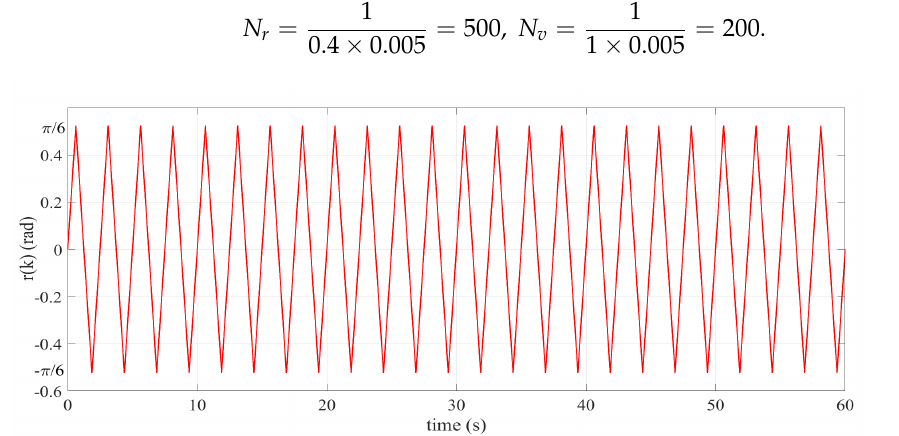
Figure 6. Repetitive reference r ( k )